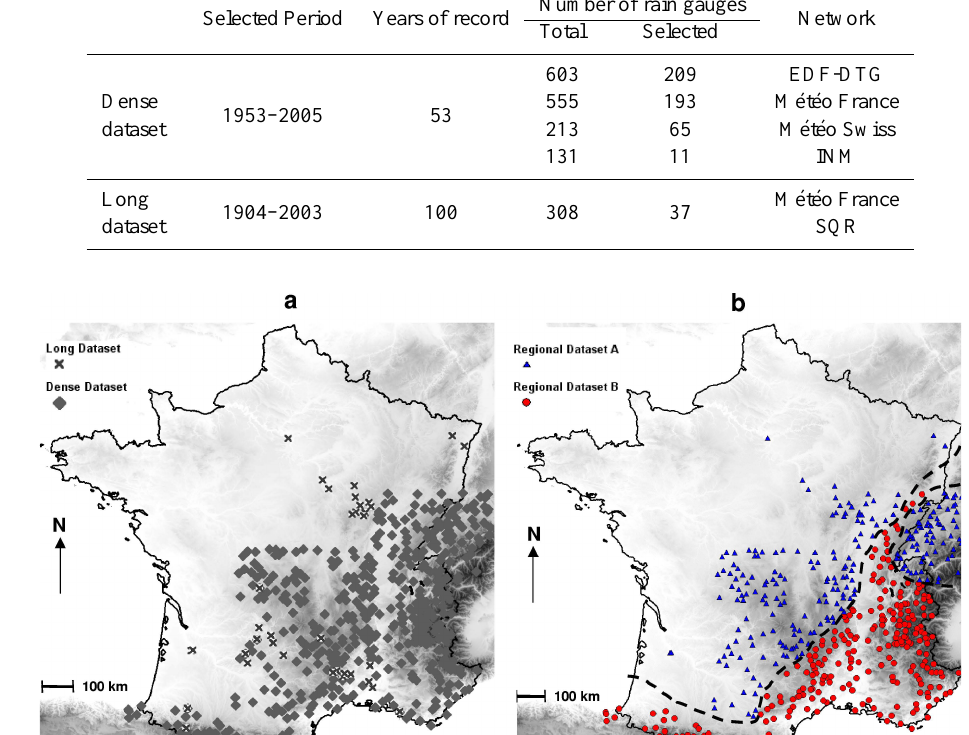
Fig. 1. (a) Rain gauges location. (b) Regional classification as a function of the “Season-at-risk”, i.e. the three consecutive months that maximize the sum of the monthly rainfall